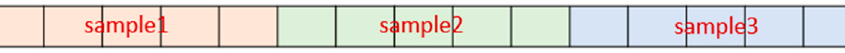
Figure 11. An example illustration of generating testing samples (n_steps = 5).